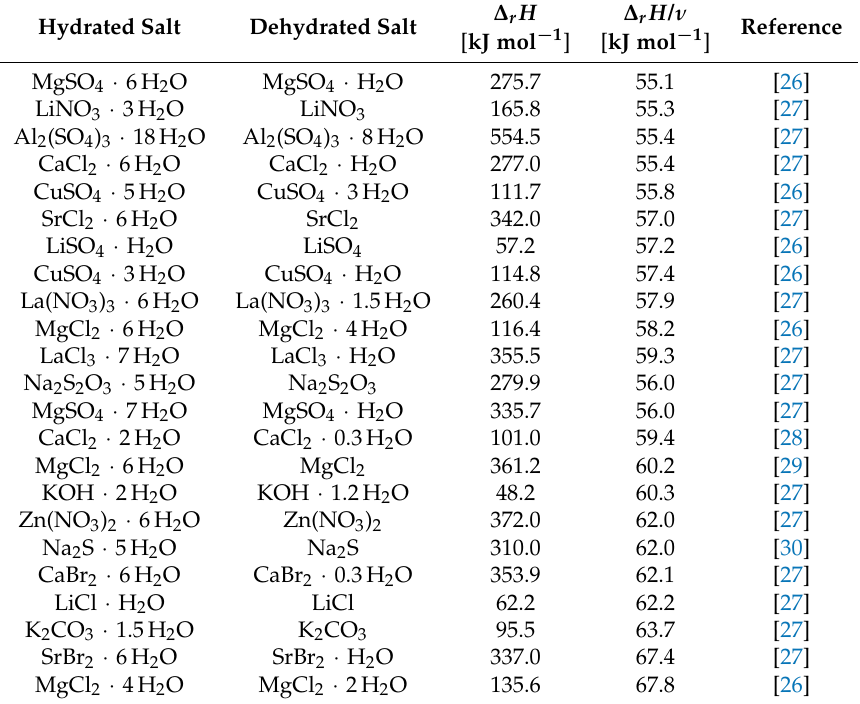
Table 1. Measured enthalpy of reaction extracted from the